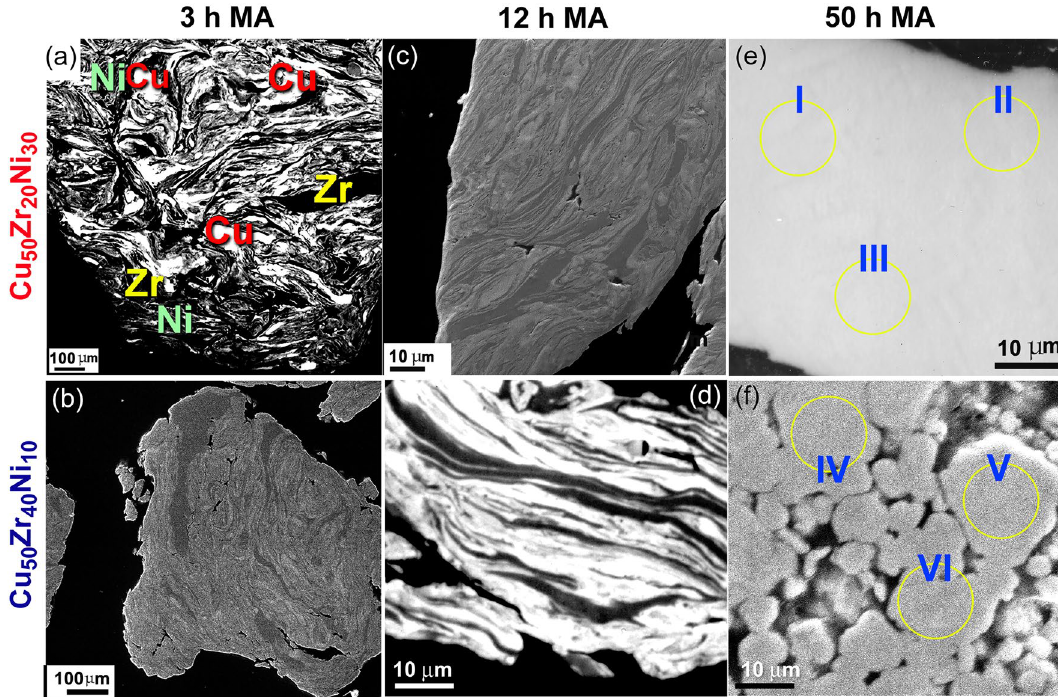
Figure 3. Metallographic characteristics of mechanically alloyed (MA) powders obtained after different stages of ball milling time. The field-emission scanning electron microscope (FE-SEM) images of MA, and Cu 50 Zr 40 Ni 10 powders obtained after 3, 12, and 50 h of low energy ball milling time, are presented in ( a ), ( c ), and ( e ) for